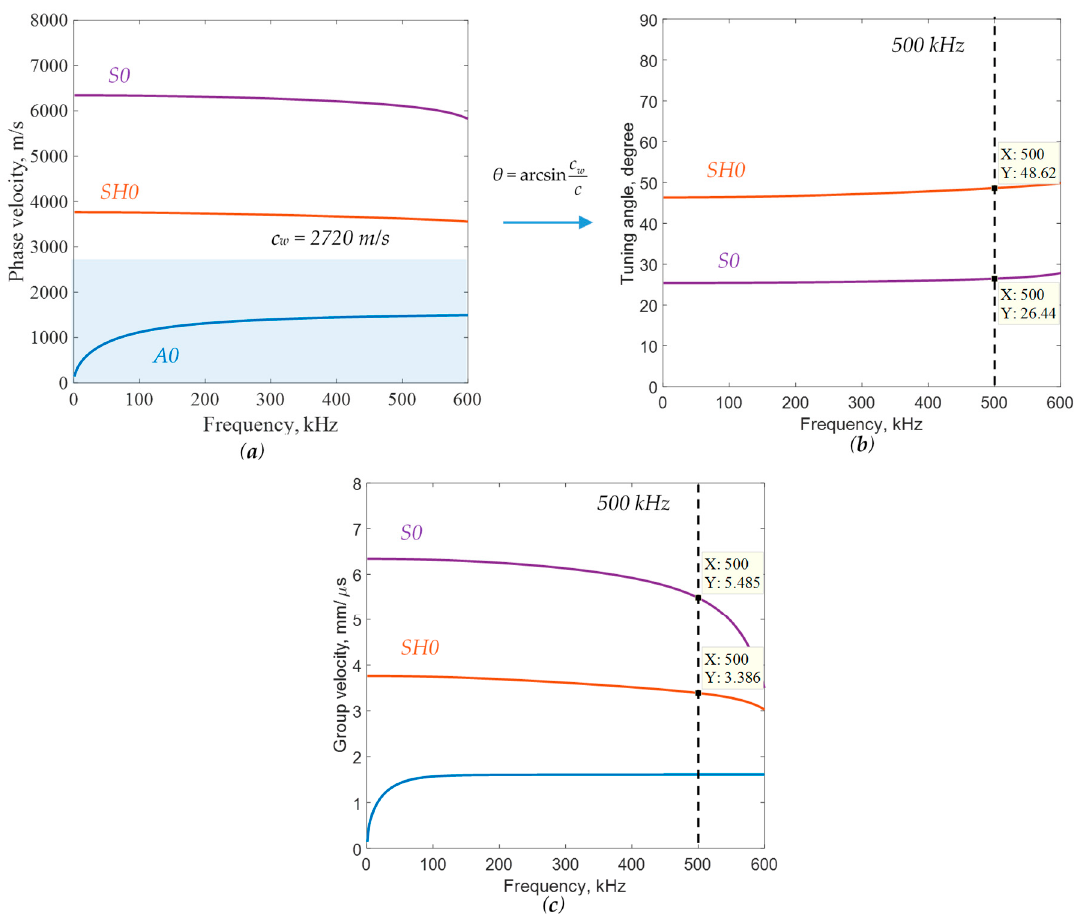
Figure 8. Dispersion curves of the 2-mm [ − 45 / 90 / 45 / 0] 2s quasi-isotropic composite plate: ( a ) phase velocity; ( b ) ABT tuning angle; ( c ) group velocity.